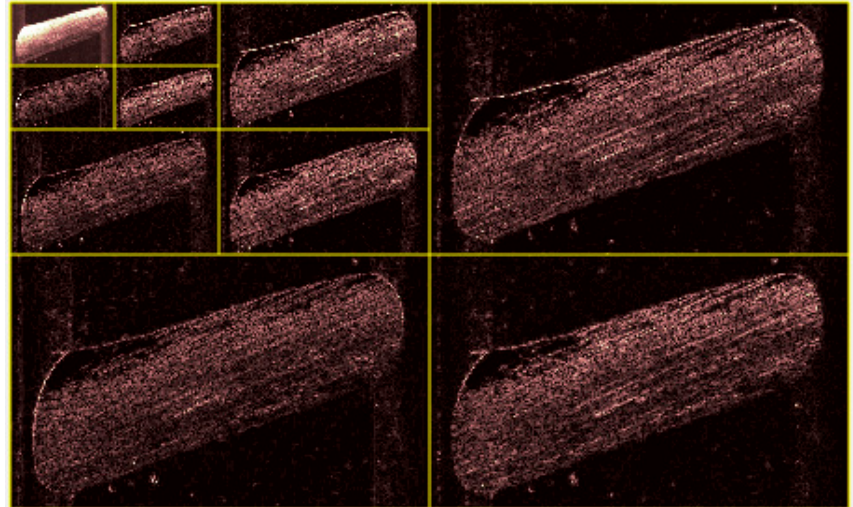
Figure 10. Multi-scale feature images.